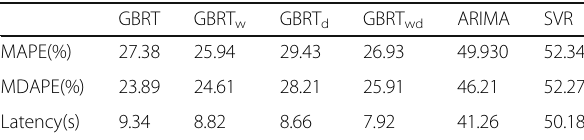
Table 3 Efficiency and